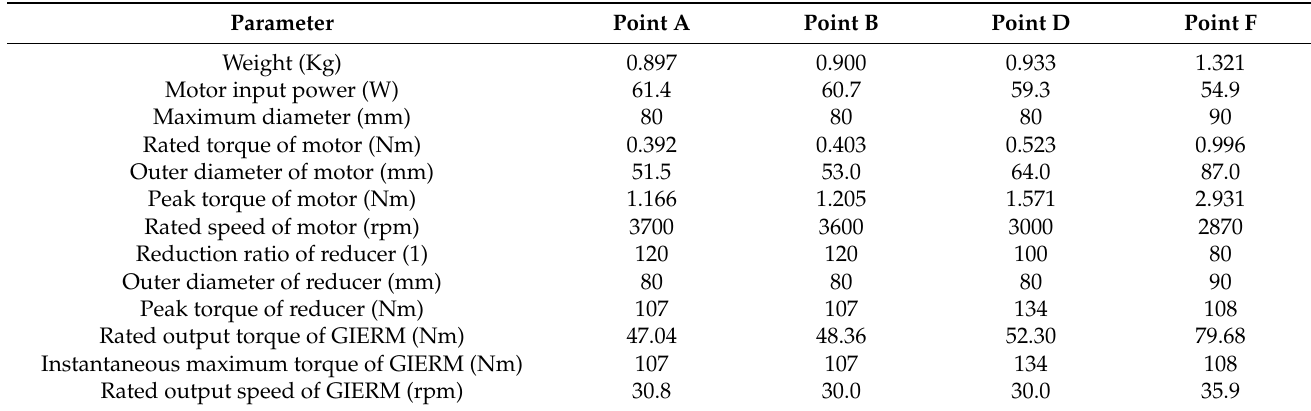
Table 5. Parameters corresponding to the performance optimization results.